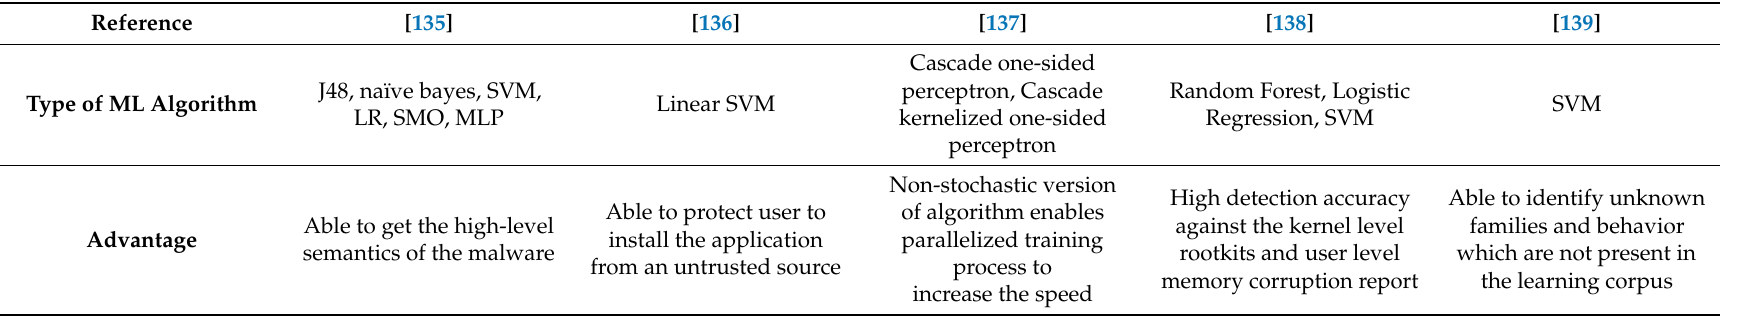
Table 10. Malware Detection Analysis (Notations: LR-Logistic Regression, SMO-Sequential Minimal Optimal, MLP- Multi-Layer